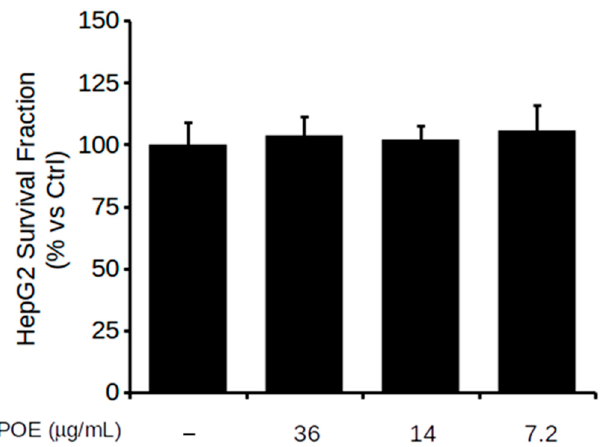
Figure 2. The effect of POE on HepG2 cell viability. MTT assay on cells untreated ( − ) or exposed to different POE concentrations for 24 h. Data were reported as the mean ± SD of at least three independent experiments.